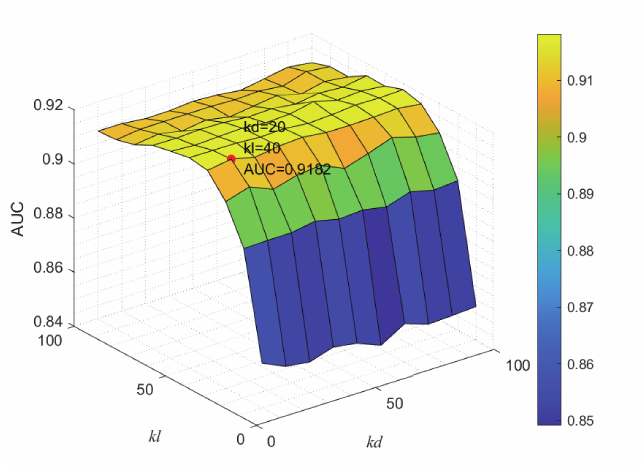
Figure 9. Sensitivity analysis of parameter η .